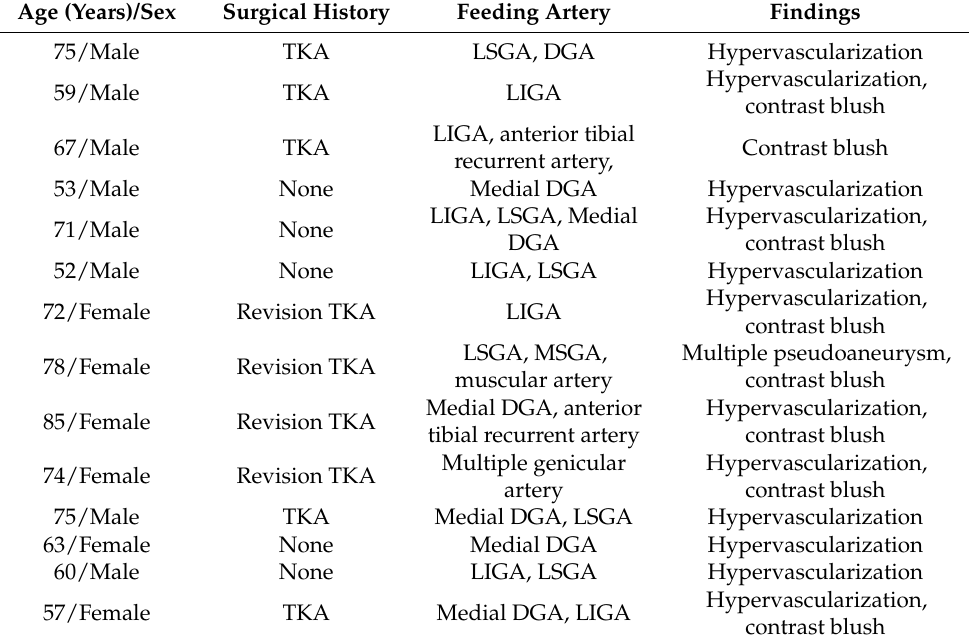
Detailed information on patients who underwent interventional angiography and selective